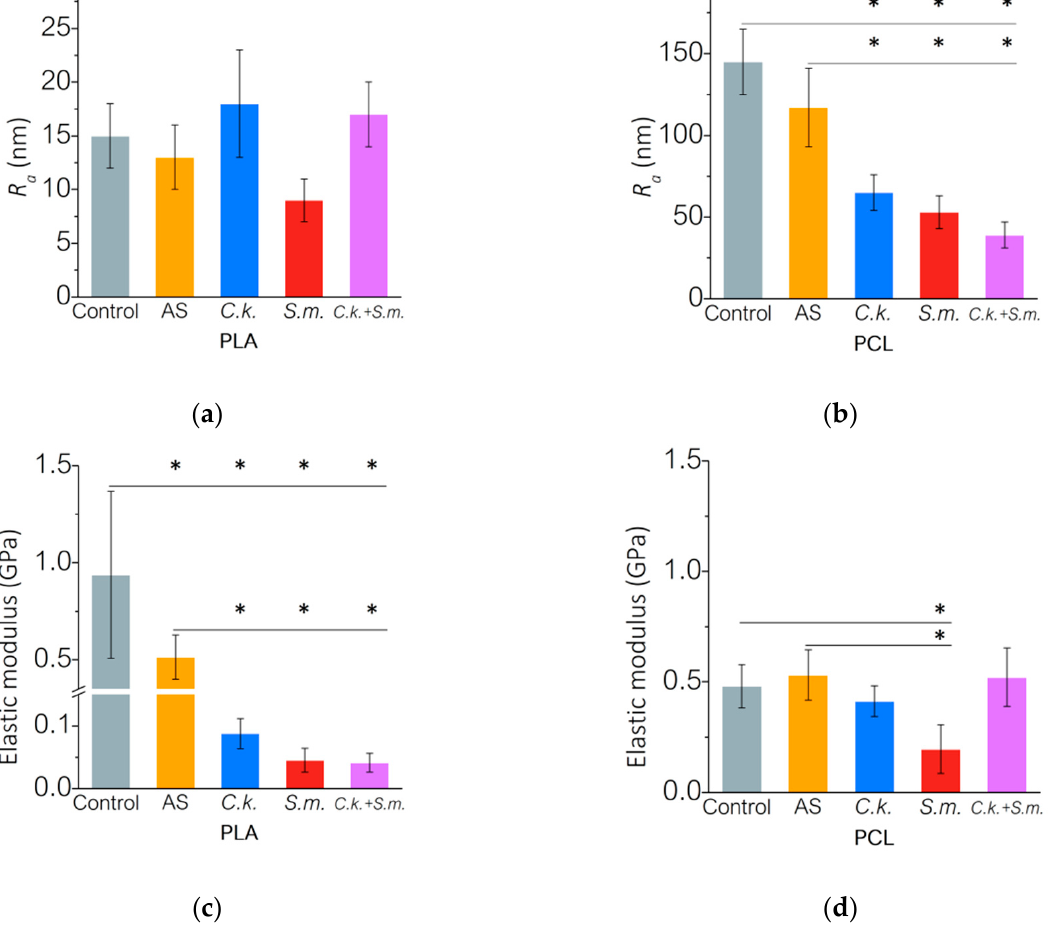
Figure 3. Surface properties of PLA and PCL after incubation: ( a , b ) roughness before and after incubation expressed by the R a parameter for PLA and PCL, respectively; ( c , d ) surface elasticity modulus before and after incubation for PLA and PCL, respectively. Results mean ± SD ( n = 3). (*) p < 0.05.